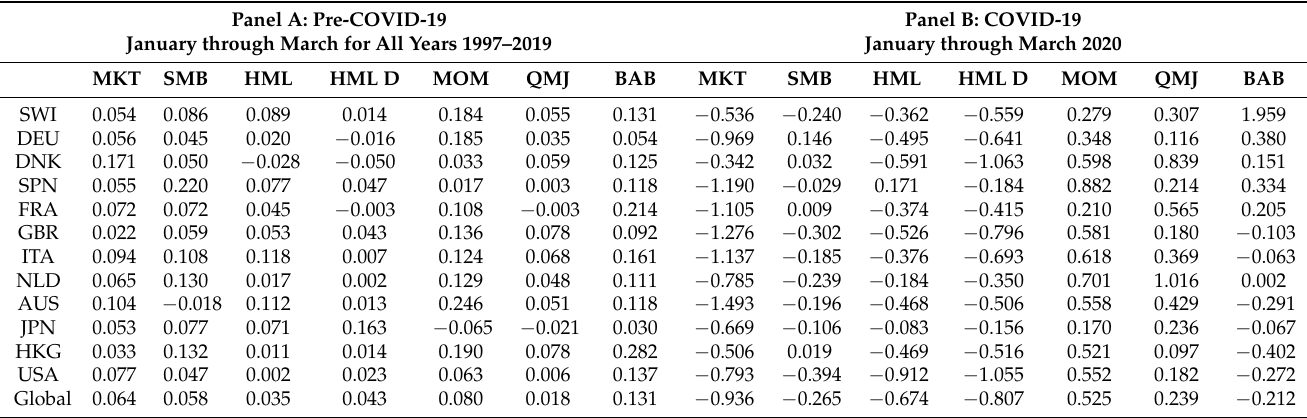
Table 1. Annualized Average